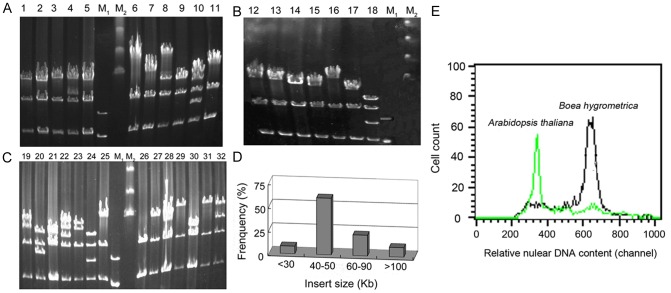
Analysis of insert size for the Boea hygrometrica BIBAC library and determination of genome size of B. hygrometrica by flow cytometry.(A–C) Pulsed-field gel electrophoresis (PFGE) patterns of 32 representatives of the 50 random BIBAC clones that were digested with NotI. PFGE gels were stained with ethidium bromide. M1, marker with bands of size 3, 5 and 8-kb; M2, Lamda ladder PFG marker with band sizes of 48.5, 97, 145 and 194-kb. (D) Insert size distributions of the 50 clones randomly selected from the B. hygrometrica BIBAC library. (E) Determination of genome size of B. hygrometrica by flow cytometry. Arabidopsis served as internal reference standard. B. hygrometrica 2C DNA content = (Boea G1 peak mean)/(Arabidopsis G1 peak mean) ×Arabidopsis 2C DNA content, the ratio of G1 peak means (B. hygrometrica: Arabidopsis) was 1.86, hence the 2C DNA amount of B. hygrometrica was estimated as 480 Mb (Arabidopsis 1C = 125 Mb).